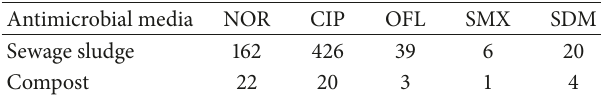
Table 1: Occurrence of antimicrobials ( 𝜇 g/kg) in sewage sludge and its compost (illustrative